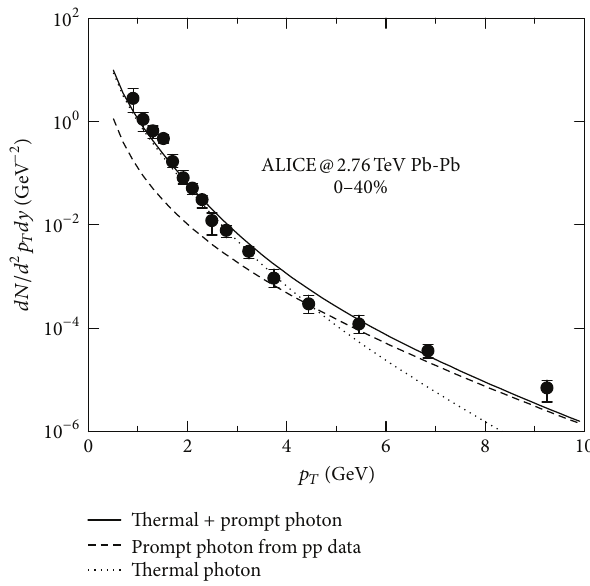
Figure7:TransversemomentumspectraofphotonsatRHICenergy for Au-Au collision for different centralities at midrapidity [12].